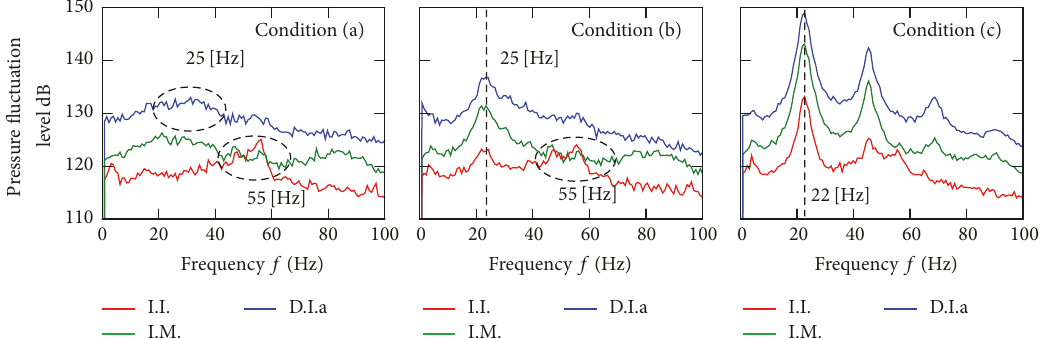
Figure 19: Power spectra of pressure fluctuations in impeller passage ( 𝜙 =